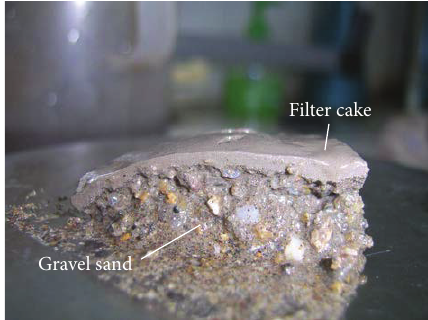
Figure 7: The 5cm thickness filter cake formed in the slurry tests.